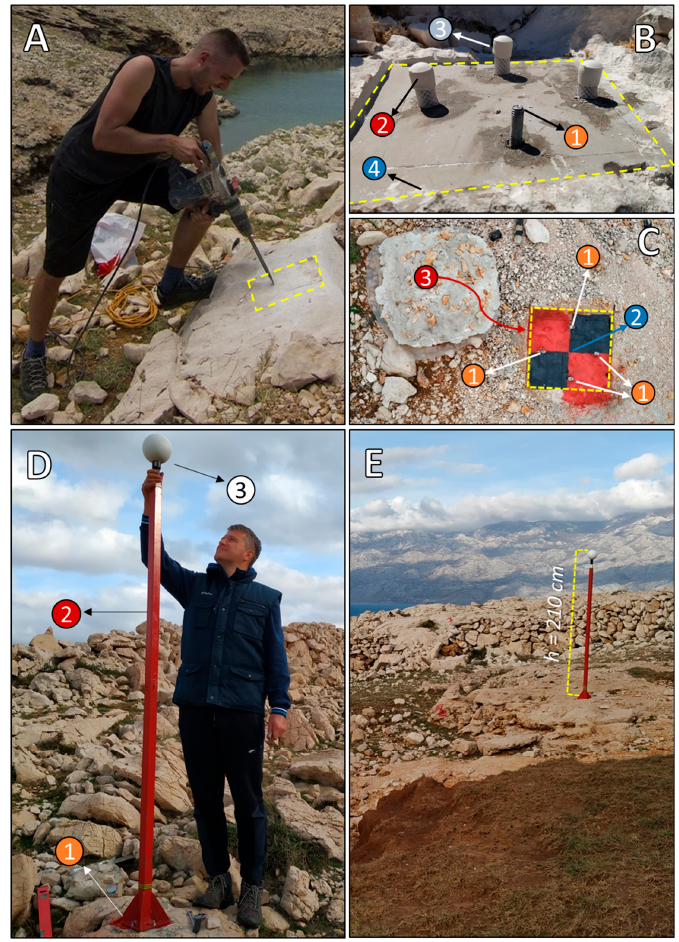
Figure 5. Methodology applied for preparation of seven PTPs distributed around the gully Santiš (( A )—carving of PMPs in carbonate badrock with hammer drill; ( B )—leveling of PMPs with self-leveling concrete (B 1 (cid:13) — anchors drilled in concrete ; B 2 (cid:13) and B 3 (cid:13) — plastic cover of metal anchors for preventing corrosion ; B 4 (cid:13) — leveled base of metal poles ); ( C )—plaster cap created for long-term protection of PTPs (C 1 (cid:13) — metal anchors ; C 2 (cid:13) — whole for measurement with RTK-GPS ; C 3 (cid:13) — gypsum protective cap ); ( D )—installation of target (sphere) on metal pole fixed to the PTP (D 1 (cid:13) — target (sphere) ; D 2 (cid:13) — designed metal pole ; D 3 (cid:13) —PTP); ( E )—example of permanent target fixed at the height of 210 cm above planned